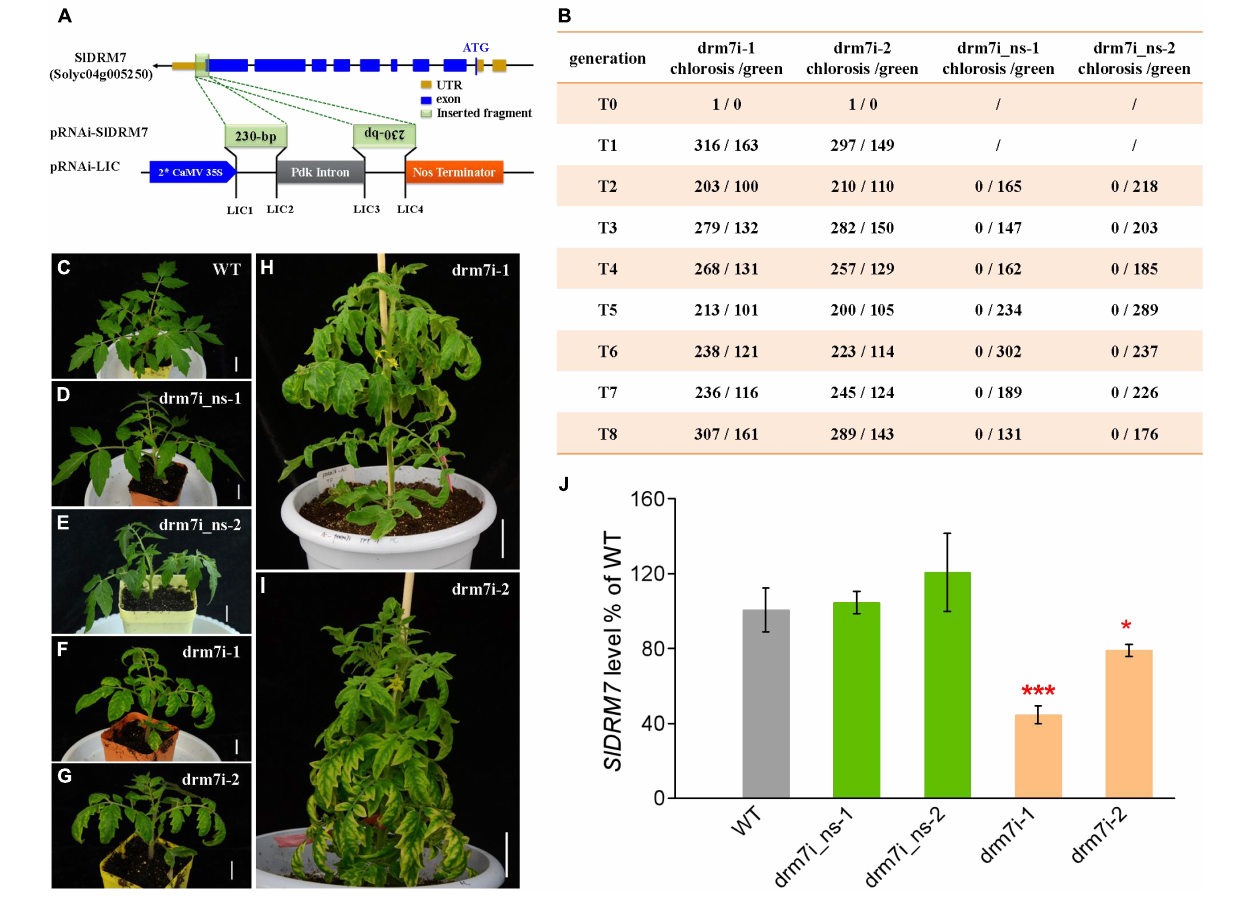
FIGURE 1 | Generation and characterization of tomato SlDRM7 -RNAi lines. (A) Schematic of the pRNAi-SlDRM7 construct. A 230-bp fragment of SlDRM7 (Solyc04g005250.2) was cloned into the pRNAi-LIC vector to generate pRNAi-SlDRM7. (B) Summary of segregation of leaf chlorosis/senescence phenotype in T0 to T8 generations of SlDRM7 -RNAi lines. The numerator represents the number of progenies of SlDRM7 -RNAi lines with maintained interveinal chlorosis/senescence leaves with kanamycin resistance, while the denominator represents the number of progenies with normal green leaves with kanamycin sensitivity. (C–I) Segregation of leaf chlorosis in SlDRM7 -RNAi lines. wild-type (WT) seedlings display normal green leaves (C) , while progenies of SlDRM7 -RNAi lines display normal WT green leaves called drm7i_ns-1 (D) , and drm7i_ns-2 (E) , whereas progenies maintain interveinal chlorosis/senescence leaves called drm7i-1 (F,H) and drm7i-2 (G,I) . Tomato seeds were spread and germinated directly in compost, and seedlings were photographed at 10 days after germination in (C–G) with bars = 1 cm, while seedlings were photographed at 6 weeks after germination in (H,I) with bars = 5 cm. (J) RT-qPCR analysis of the relative expression levels of SlDRM7 in leaves of WT and SlDRM7 -RNAi lines at the six-leaf stage. Data are means ± SD of five biological replicates. Asterisks indicate the significant differences compared with WT (* P ≤ 0.05, *** P ≤ 0.001, one-way ANOVA, Tukey’s HSD). No difference with statistical significance was found for WT vs. drm7i_ns-1, and WT vs.